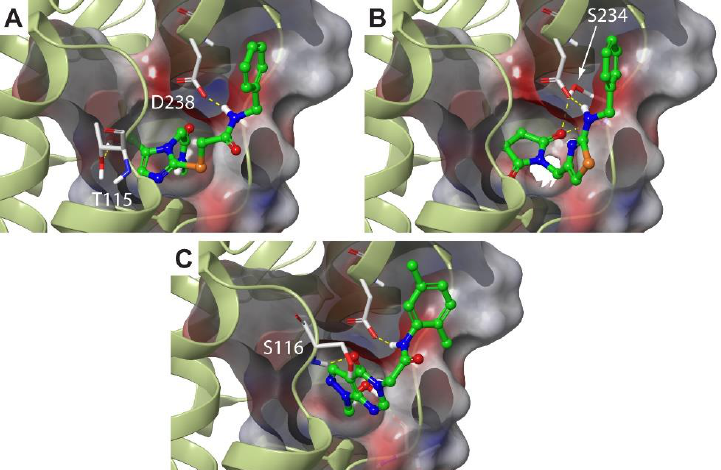
Figure 4. Docking poses for Compounds L1–3 (Panels A – C , respectively) in the F#2 site. Hp (UreF) 2 ribbons are in dark green, and residues involved in the binding are labeled and depicted as thin sticks colored according to atom type. The L1–3 compounds are shown as green sticks, where heteroatoms are colored according to atom type. Hydrogen bonds are shown using yellow dashed lines.